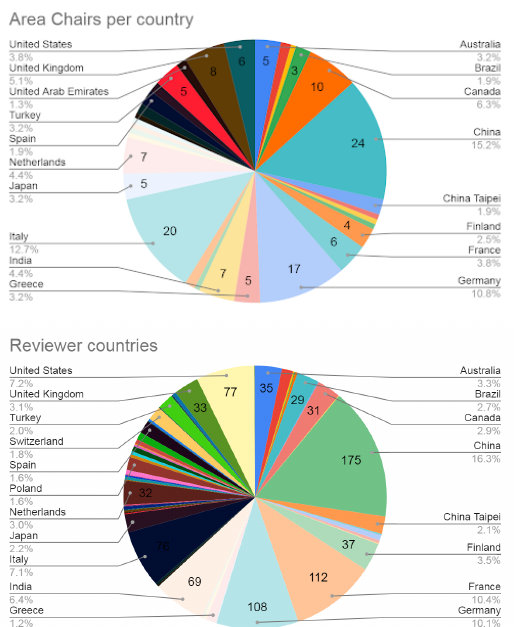
Figure 3. Area Chairs and reviewers per country.